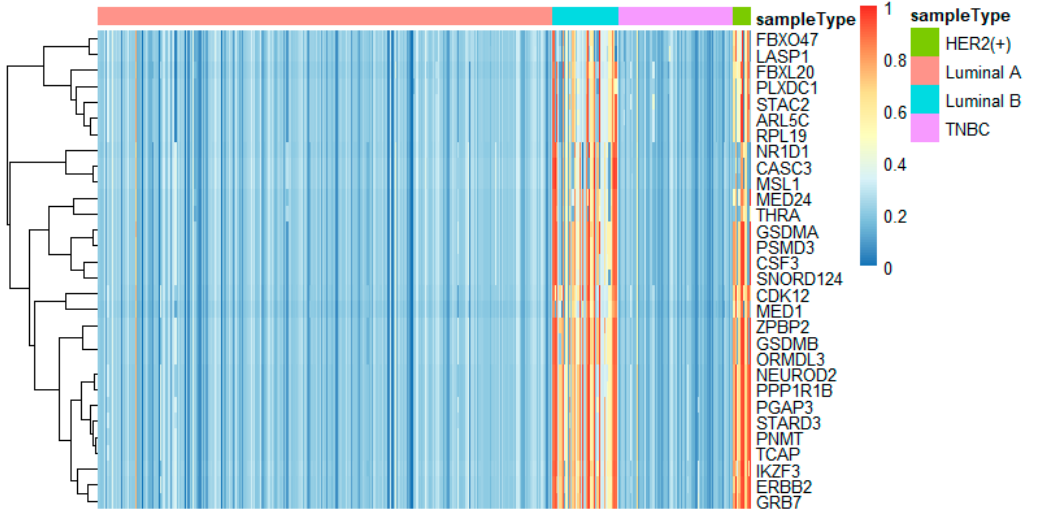
Figure 11. The heatmap of breast cancer subtypes on CNV data.